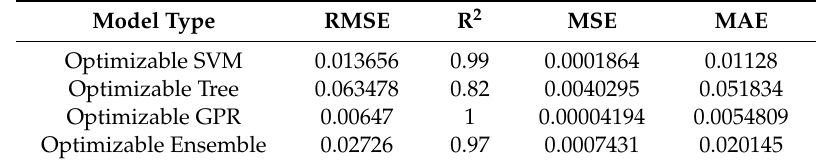
Table 5. Combinations of hyperparameter optimization models error measures.